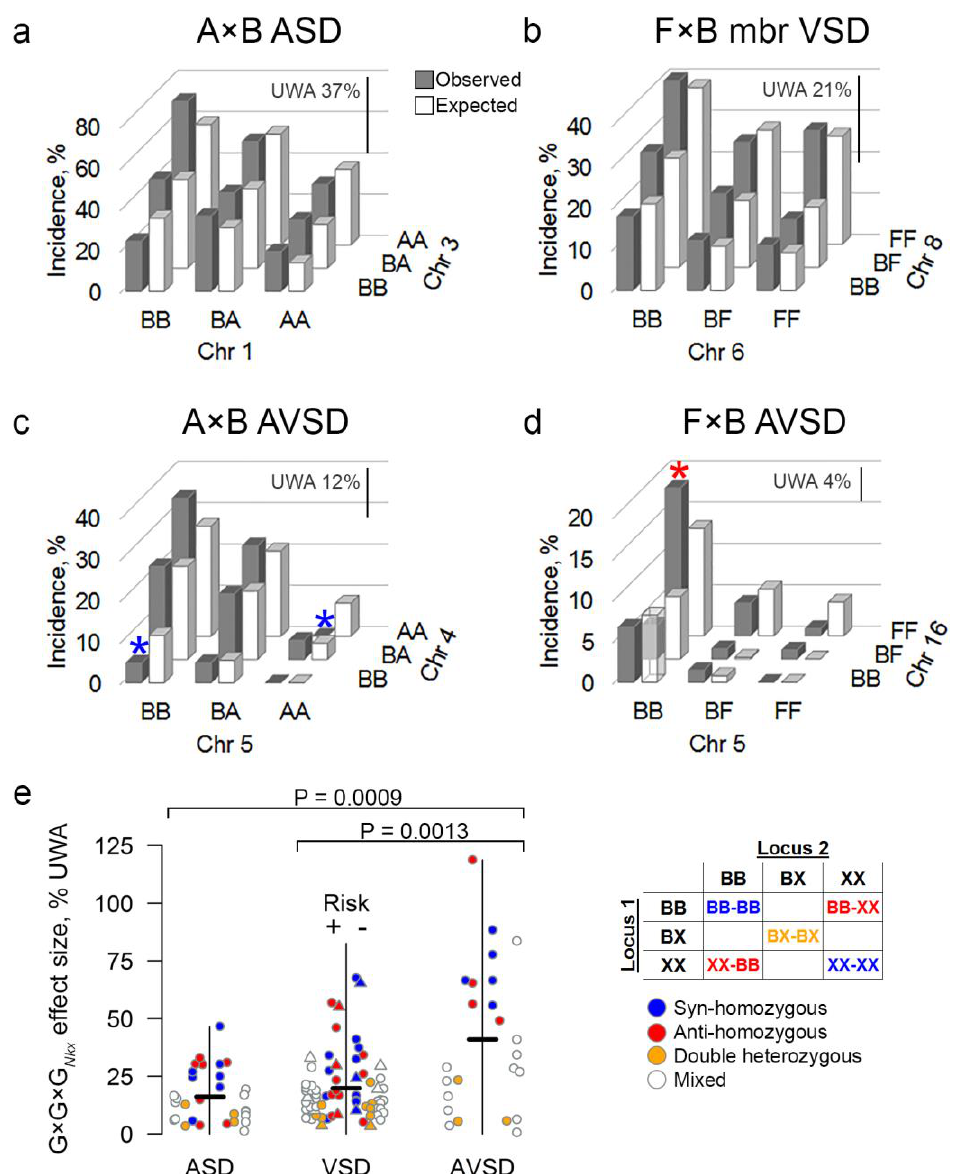
Figure 3. G × G × G Nkx effects correlate with the severity of a heart defect. Representative plots depict the observed and expected incidence of a defect at a two-locus genotype. The expected incidence is calculated under the null hypothesis of non-interacting loci. The difference between the observed and expected incidences is the G × G × G Nkx effect at a genotype. Not all differences are significant. ( a , b ) ASD and VSD loci mainly contribute to risk independently, as indicated by similar observed and expected incidences. Significant G × G × G Nkx effects are small relative to the unweighted average of incidences (UWA %, scale bars) across all nine genotypes. ( c , d ) Epistatic interactions between AVSD loci exert large G × G × G Nkx effects. Consider examples from two crosses. The syn-homozygous, AA–AA and BB–BB genotypes (blue *) in the A × B intercross suppress risk significantly. In contrast, half of the AVSDs in the F × B intercross are associated with an anti-homozygous, Chr 5-Chr 16 BB–FF genotype (red *). ( e ) G × G × G Nkx effect sizes correlate with defect severity (Kendall’s τ = 0.195, P = 0.0017). AVSD effects are larger than ASD and VSD (Mann–Whitney U test). Significant G × G × G Nkx effects were divided by the UWA and shown as absolute values because the net deviation of observed and expected incidences is zero. The sign indicates whether a significant effect increases (+) or decreases ( − ) risk. The hatch marks indicate the mean. Effects are color-coded by their two-locus genotypes, as given in the Punnett square for syn- and anti-homozygous, double heterozygous, and mixed genotypes. Two-locus genotypes for muscular (triangle) and membranous (circle) VSD are indicated. Alleles: B, C57BL/6N; X, A/J or FVB/N.